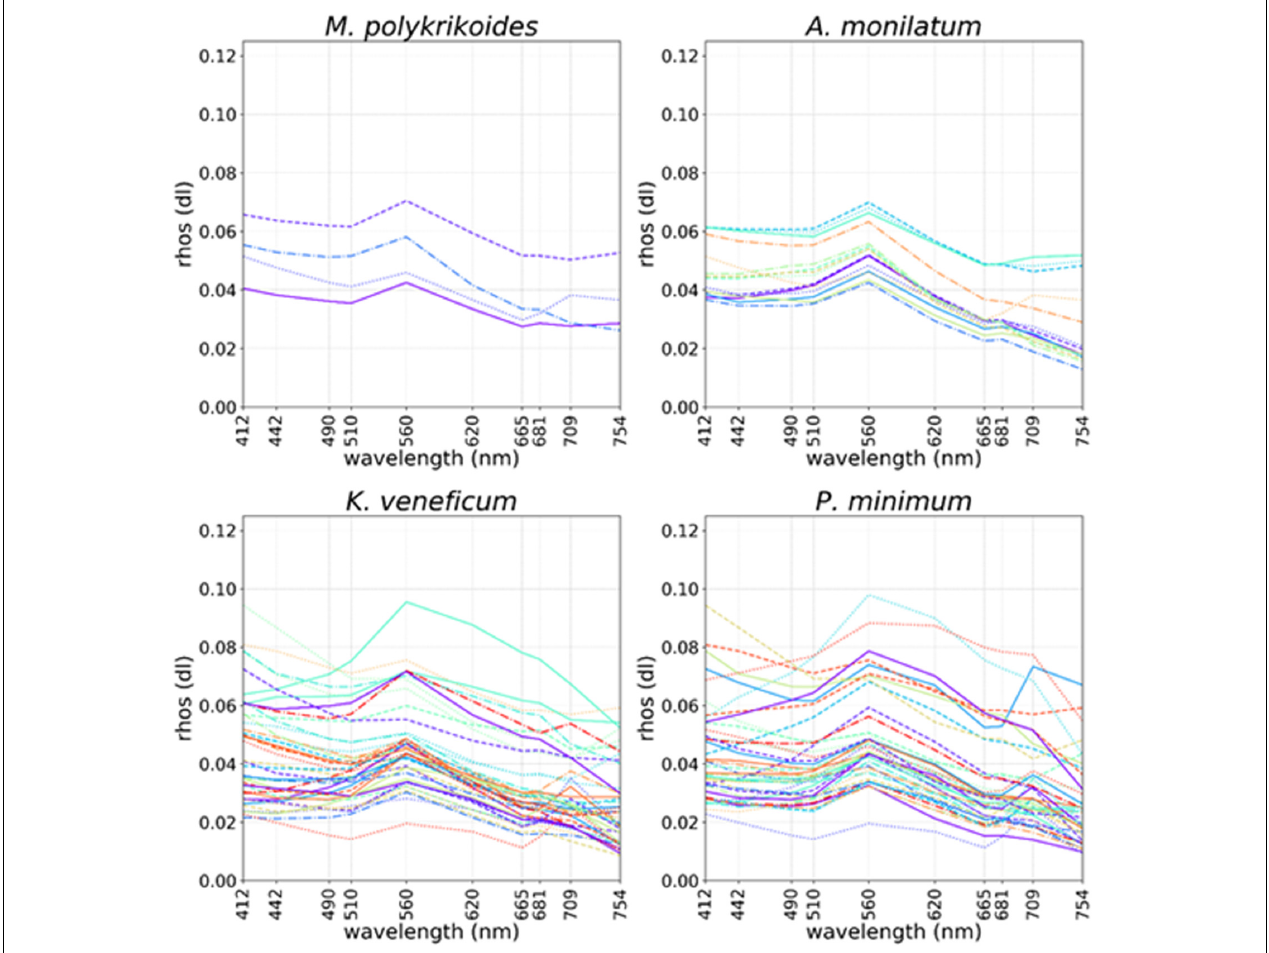
FIGURE 1 | Ocean and Land Colour Imager (OLCI) R rhos spectral plots coinciding with locations of in situ cell concentrations > 50,000 cells L − 1 collected on the same day for Margelefidinium polykrikoides (top left) , Alexandrium monilatum (top right) , Karlodinium veneficum (bottom left) , and Prorocentrum minimum (bottom right) . Colored lines and random linestyles were used for better separation of individual